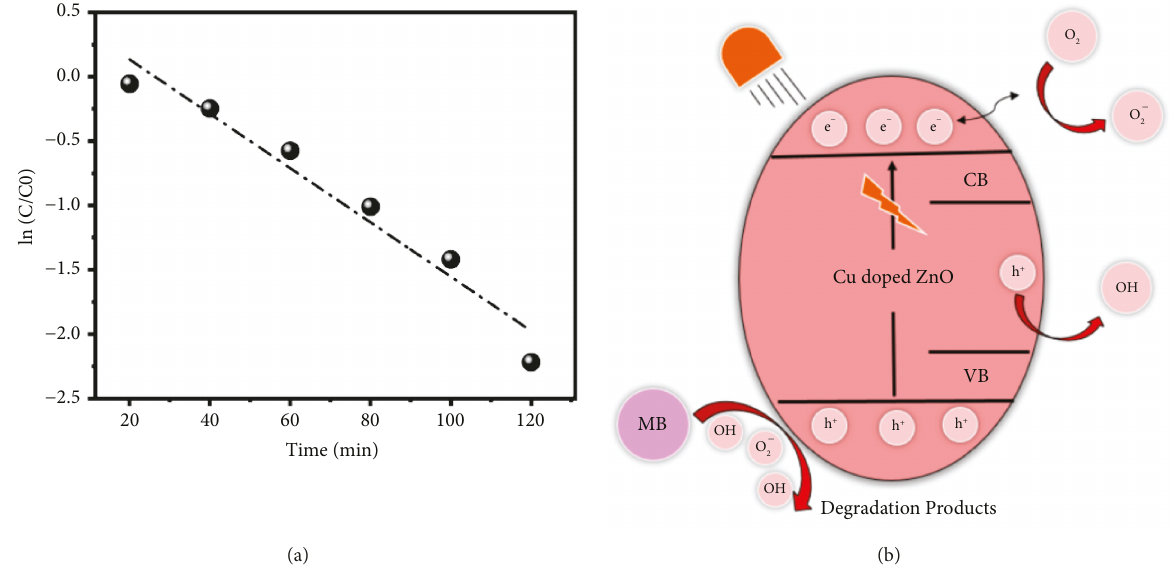
Figure 9: (a) Plot of ln (Co/Ct) versus time for illustrating the kinetics of photodegradation. (b) Charge transportation process of Cu-doped ZnO NPs leading to photocatalytic dye degradation.